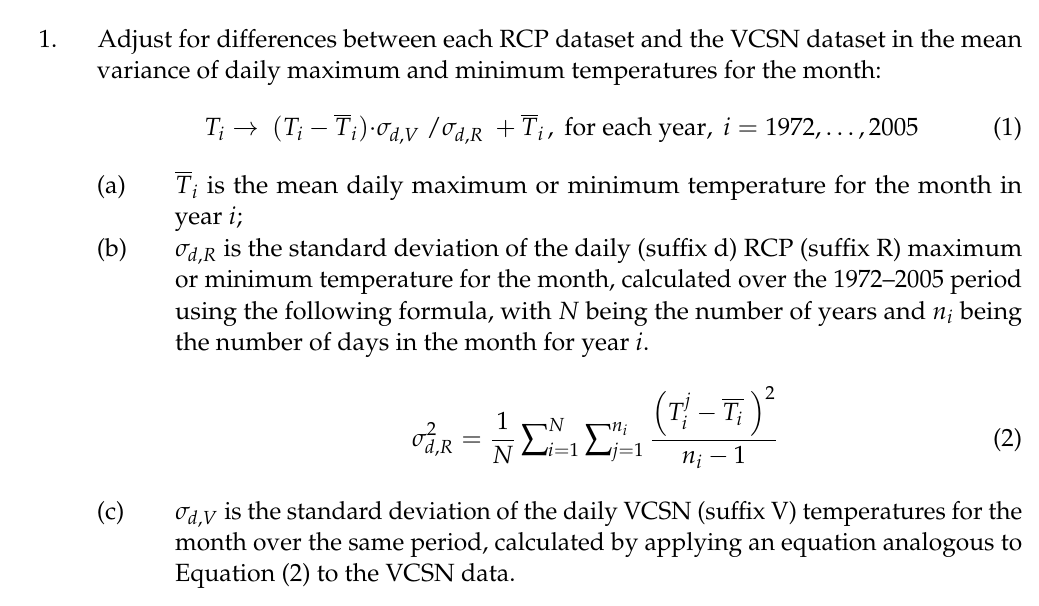
Figure 2. Schema to show the effect of Steps 1 and 2 in the adjustment procedure above. For each calendar month, M, Step 1 (left hand side) scales daily temperatures around their mean by the same scale factor, S 1 , for each year. Step 2 (right hand side) scales the monthly means around the trend in the monthly mean by the same scale factor, S 2 , for each year. Step 2 results in a translation of the temperature distributions for each month and year that is proportional to the scale factor and the deviation of the mean from the trend, without affecting the variance of the daily temperatures.